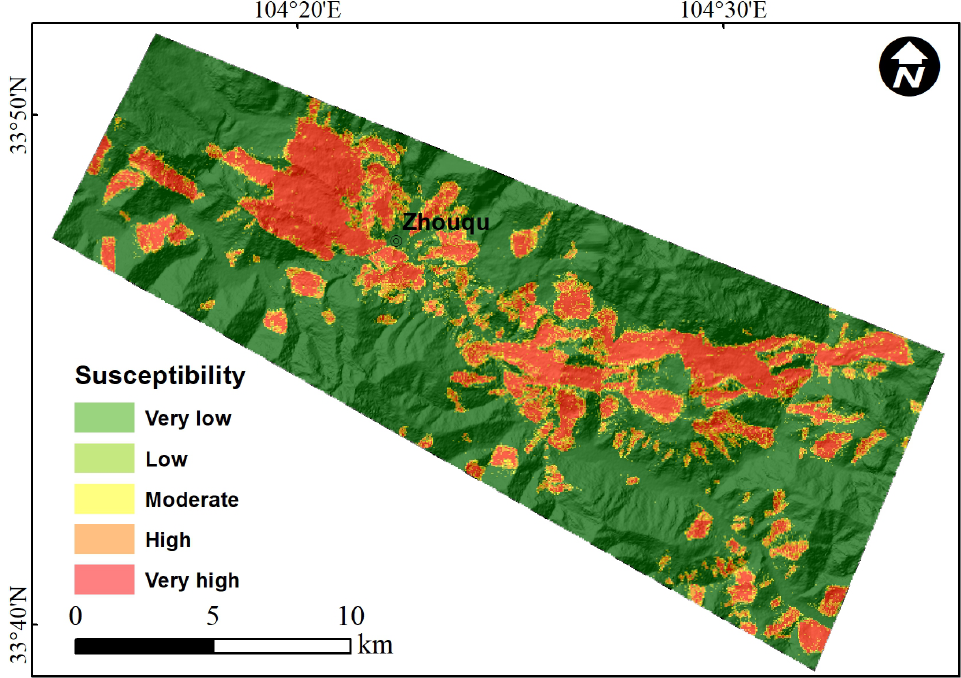
Figure 9. Mapping results of landslide susceptibility in study